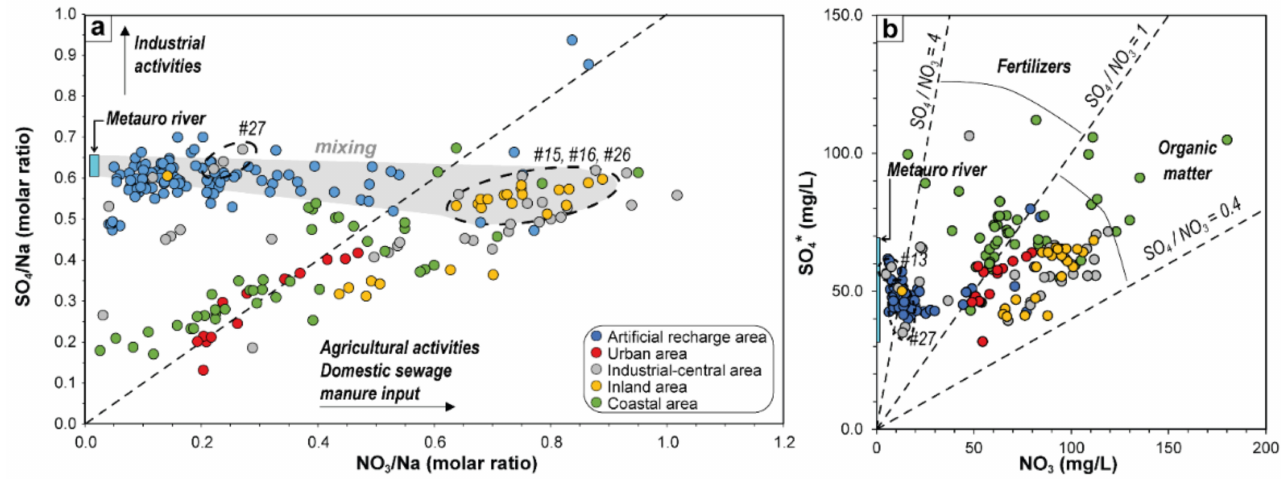
Figure 7. ( a ) Binary diagram of SO 4 /Na vs. NO 3 /Na (as molar ratios) for the investigated samples, where the dashed line represents a 1:1 ratio. ( b ) Plot of SO 4 * vs. NO 3 , where the dashed lines define the different ratios discriminating the sources of pollution (after Busico et al. [63], Cuoco et al. [76] and Rufino et al. [77]). Metauro River fields from Nisi et al.